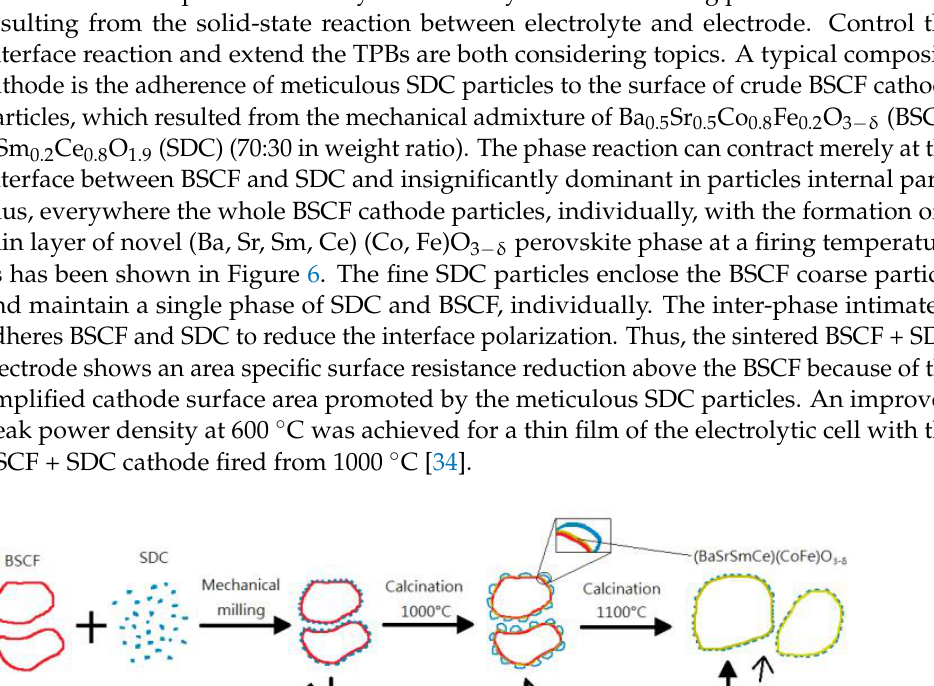
6 of 23 Figure 5. SEM micrographs of the cross-sections of: ( a ) pure YSZ anode backbone; ( b ) ∼ 5 wt.% LSCrM-impregnated YSZ anode; ( c ) ∼ 35 wt.% LSCrM-impregnated YSZ anode; ( d , e ) LSCrM/Ni/Ag